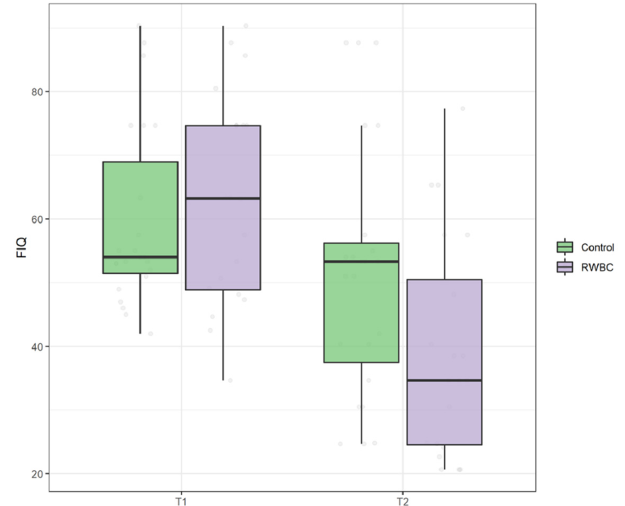
Figure 4. Boxplot of Fibromyalgia Impact Questionnaire (FIQ) scores at T0 and T1 in control group and intervention group (RWBC).